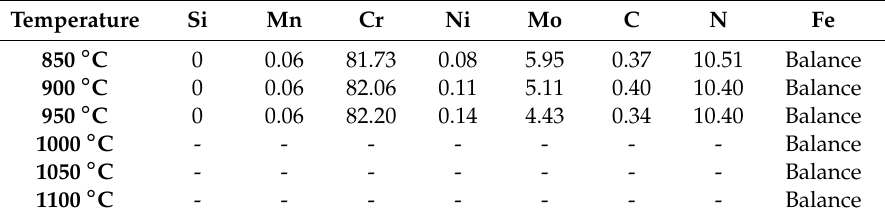
Table 6. Nitrides composition calculated with